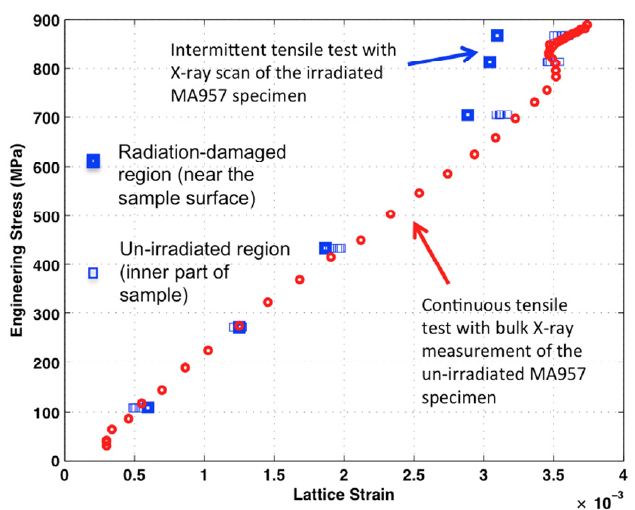
Figure 8. {110} lattice strain evolutions for both un-irradiated and irradiated MA957 samples: the blue squares show lattice strain values during the intermittent tensile test for the irradiated MA957 specimen; the red circles show lattice strain values during the continuous tensile test for the un-irradiated MA957 specimen. The uncertainty in lattice strains is about ±4 × 10 − 4 .